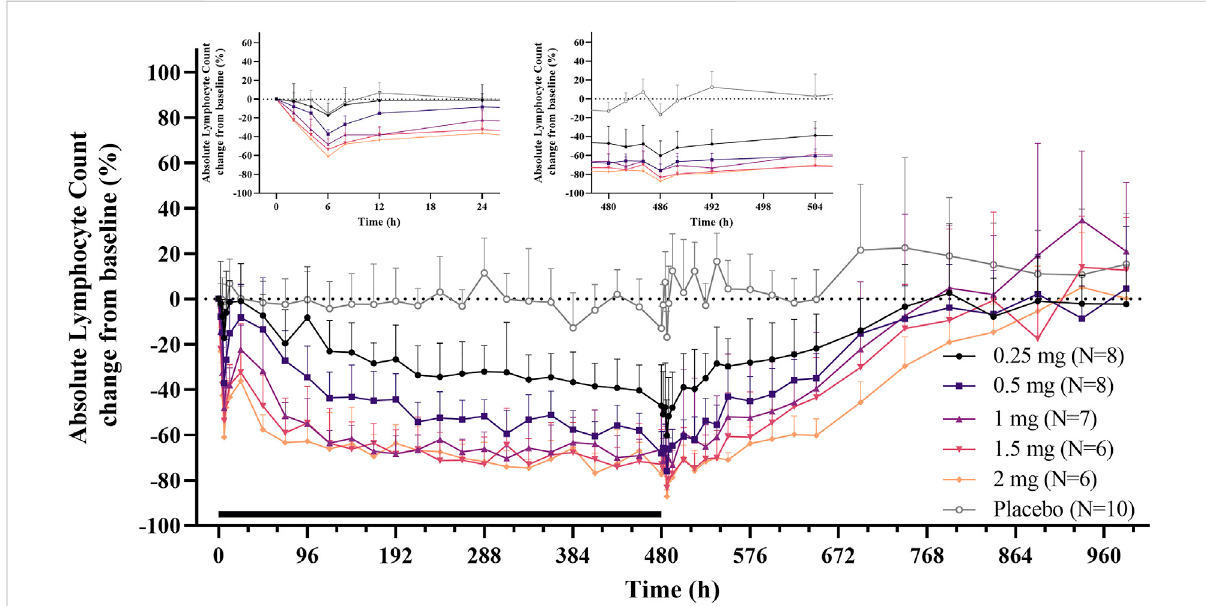
h pro fi les after the fi rst and last